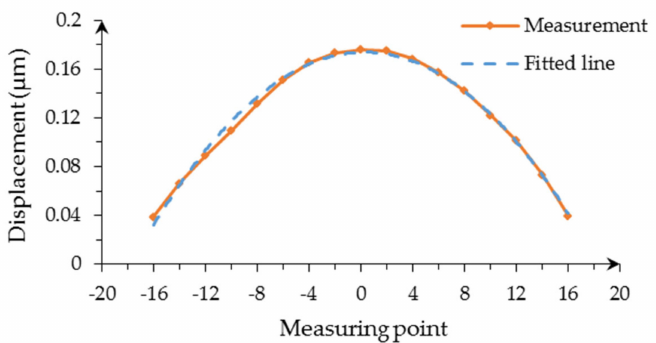
Figure 7. The maximum displacement of each point and the fitted